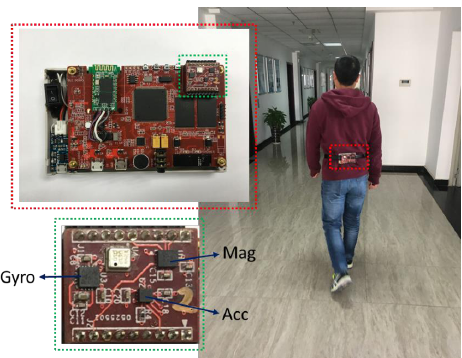
Figure 5. Experimental system and indoor test environment.